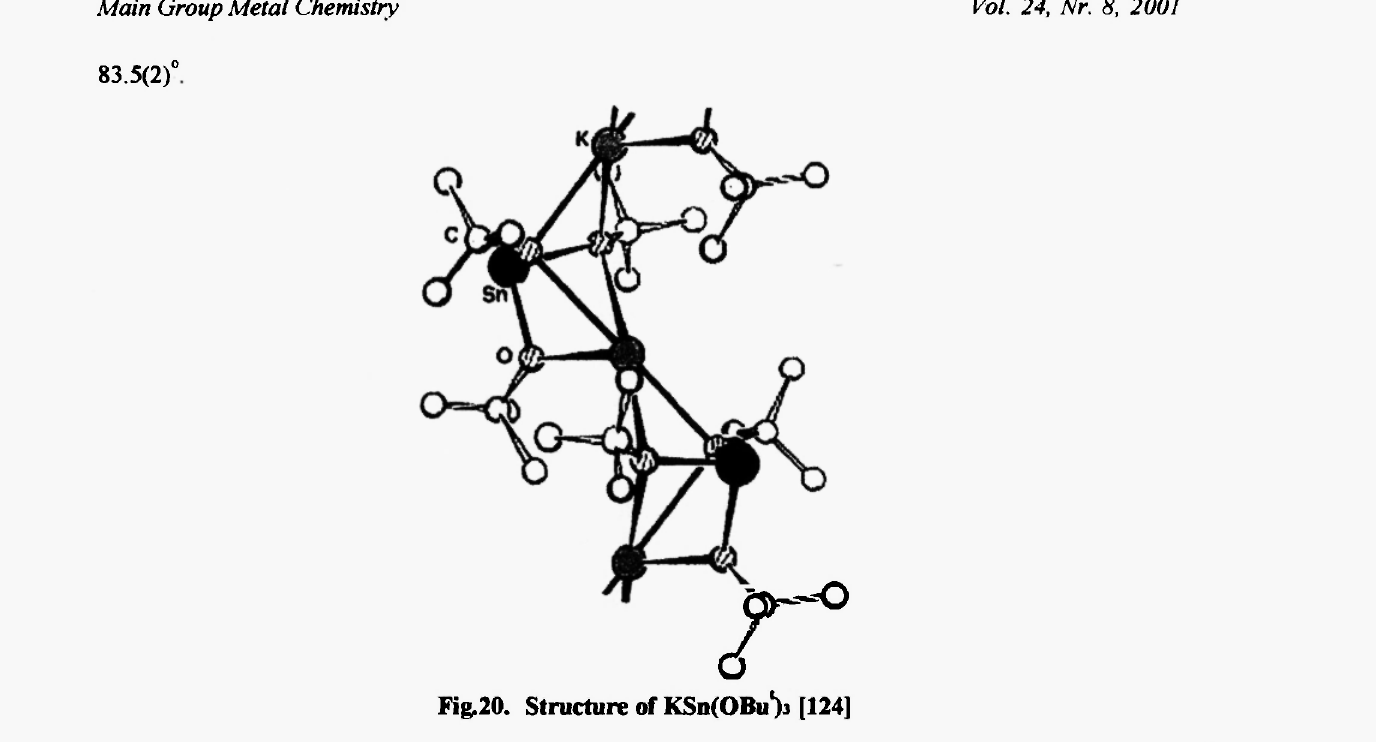
Fig.20. Structure of KSniOBu'jj